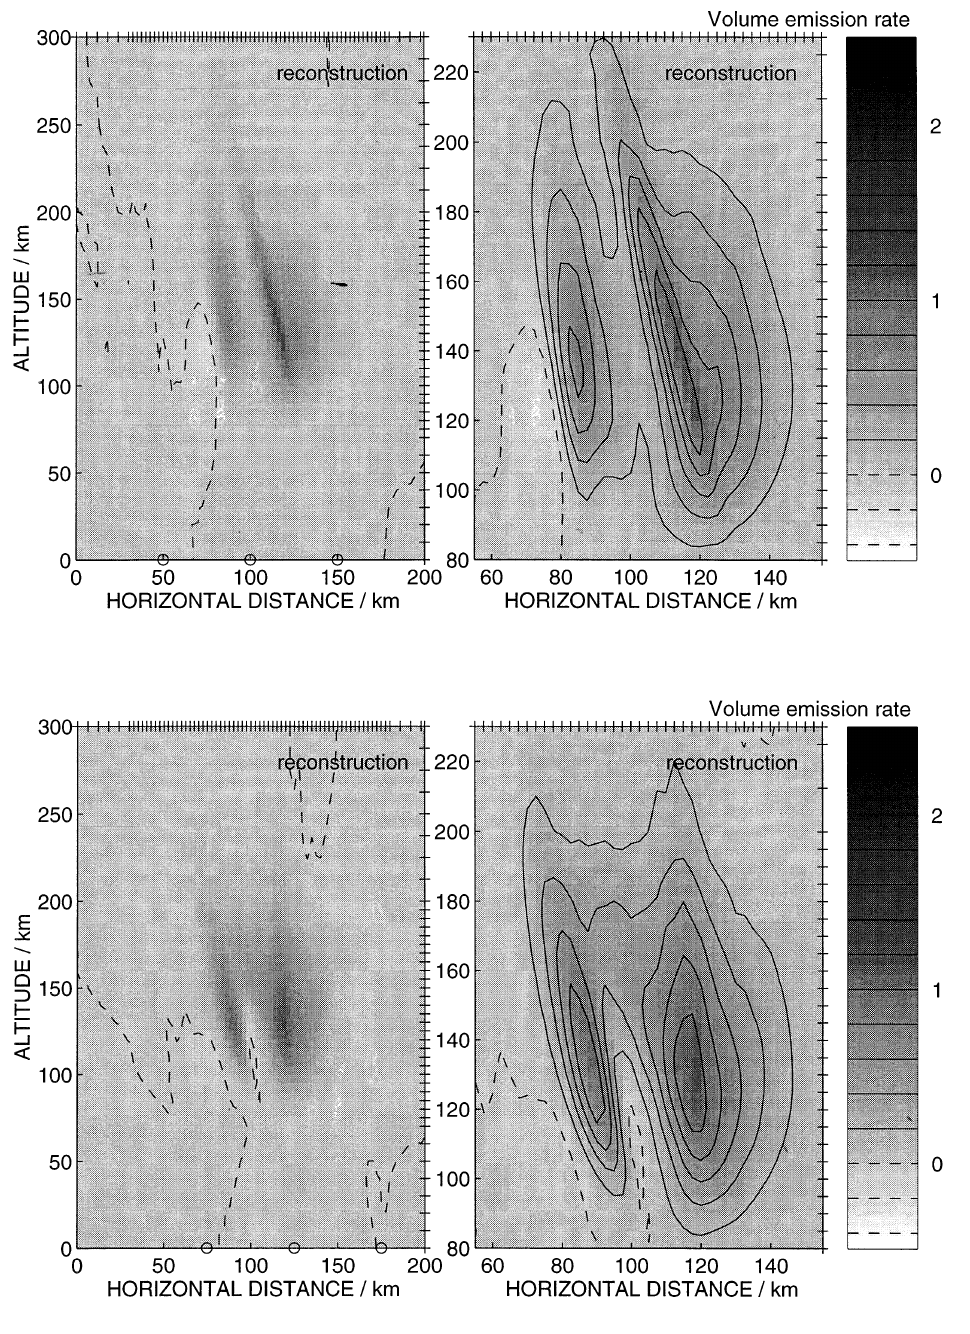
Fig. 6. Same as Fig. 4 for three receivers at 75, 125 and 175